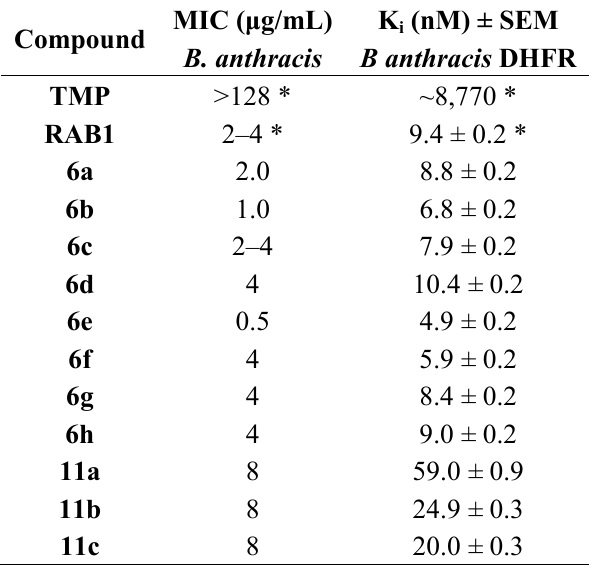
Table 1. MIC and K values of the substrates 6a – h and 11a – c against B. i